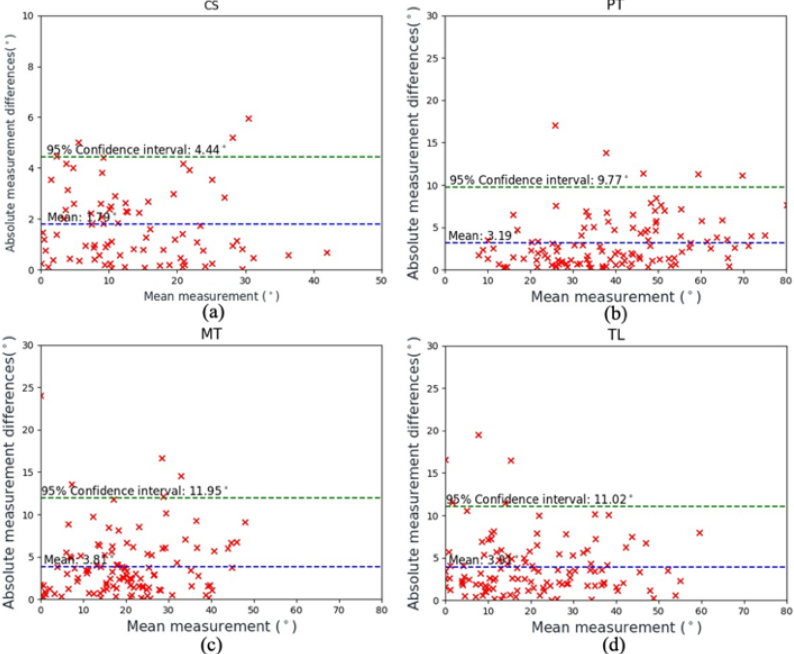
Figure 4. Correlation scatter diagrams. ( a ) Diagram for our own dataset. ( b – d ) are the diagrams for the public datasets. Each cross represents the prediction and corresponding differences of the Cobb angles.